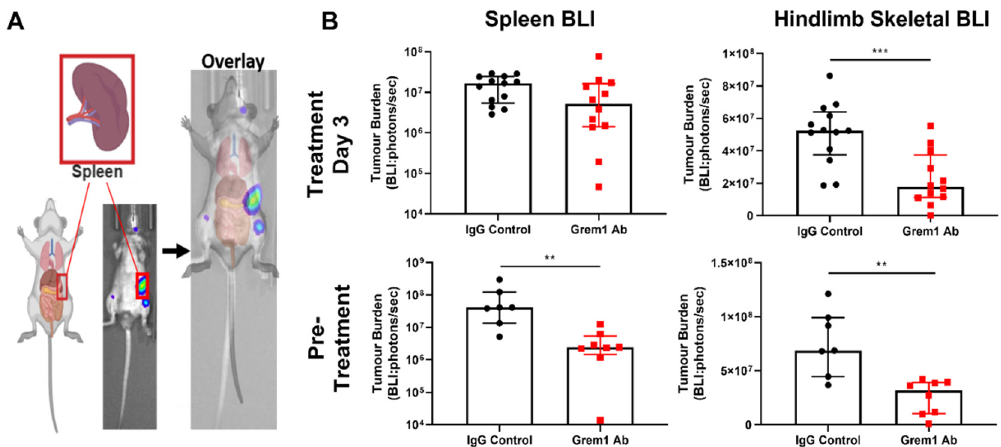
Figure 6. Anti-Grem1 antibody treatment in 5TGM1 tumor-bearing mice specifically reduces skeletal tumor burden, but not splenic tumor burden. ( A ) Schematic illustrating the detection of splenic tumor signal by BLI. ( B ) Final BLI scans for anti-Grem1 treatment regimens started either three days posttumor cell inoculation (posttreatment) or prior to 5TGM1 tumor cell inoculation (pretreatment) measuring BLI tumor signal from the splenic region and skeletal BLI of the long bones. Graphs depict median ± interquartile range, posttreatment spleen: n = 13; posttreatment long bones: n = 13; pretreatment spleen: n = 7; and pretreatment long bones: n = 8. ** p < 0.01, *** p < 0.001, Mann–Whitney test.